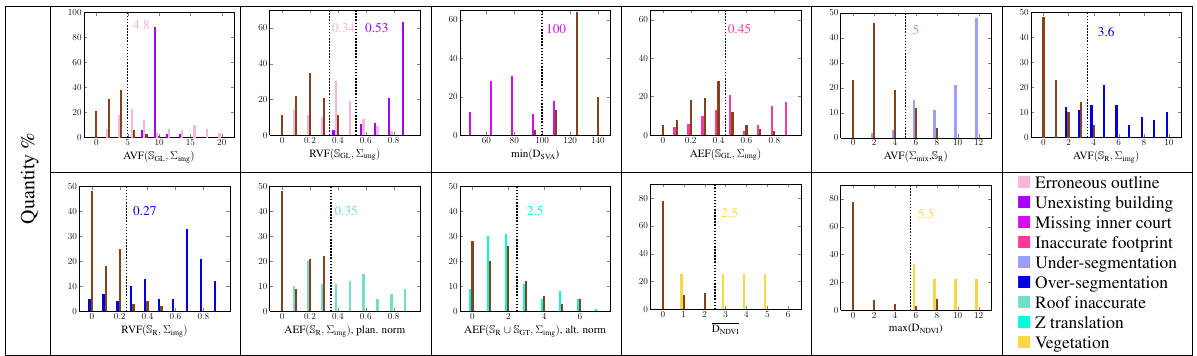
Figure 5: Error detection using one-against-all method (training set). n : complement of each evaluated error. - -: computed threshold.